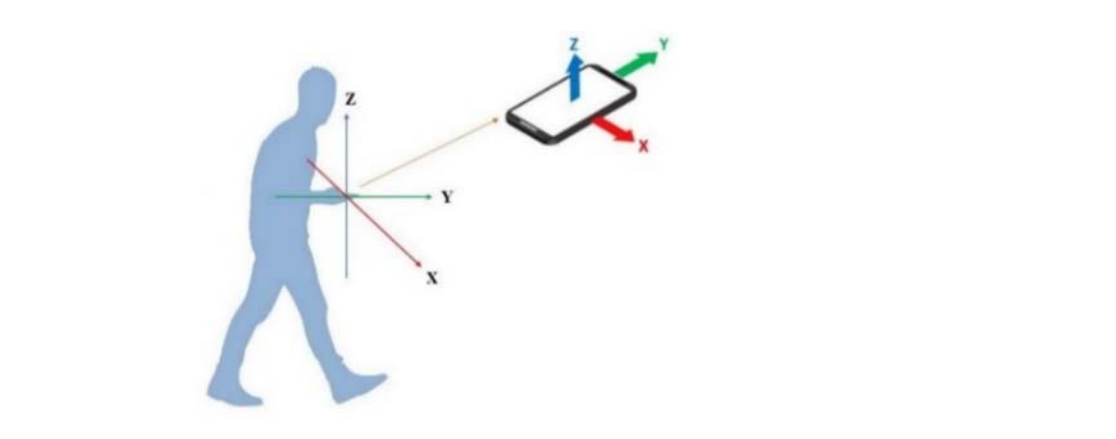
Figure 2. The sketch of using the phone with pose of ‘holding’. The person holds the phone horizontally. The pointing directions of the three orthogonal coordinate axes of the phone frame system are X -axis pointing towards the right, Y -axis pointing towards the front, and Z -axis pointing upwards.